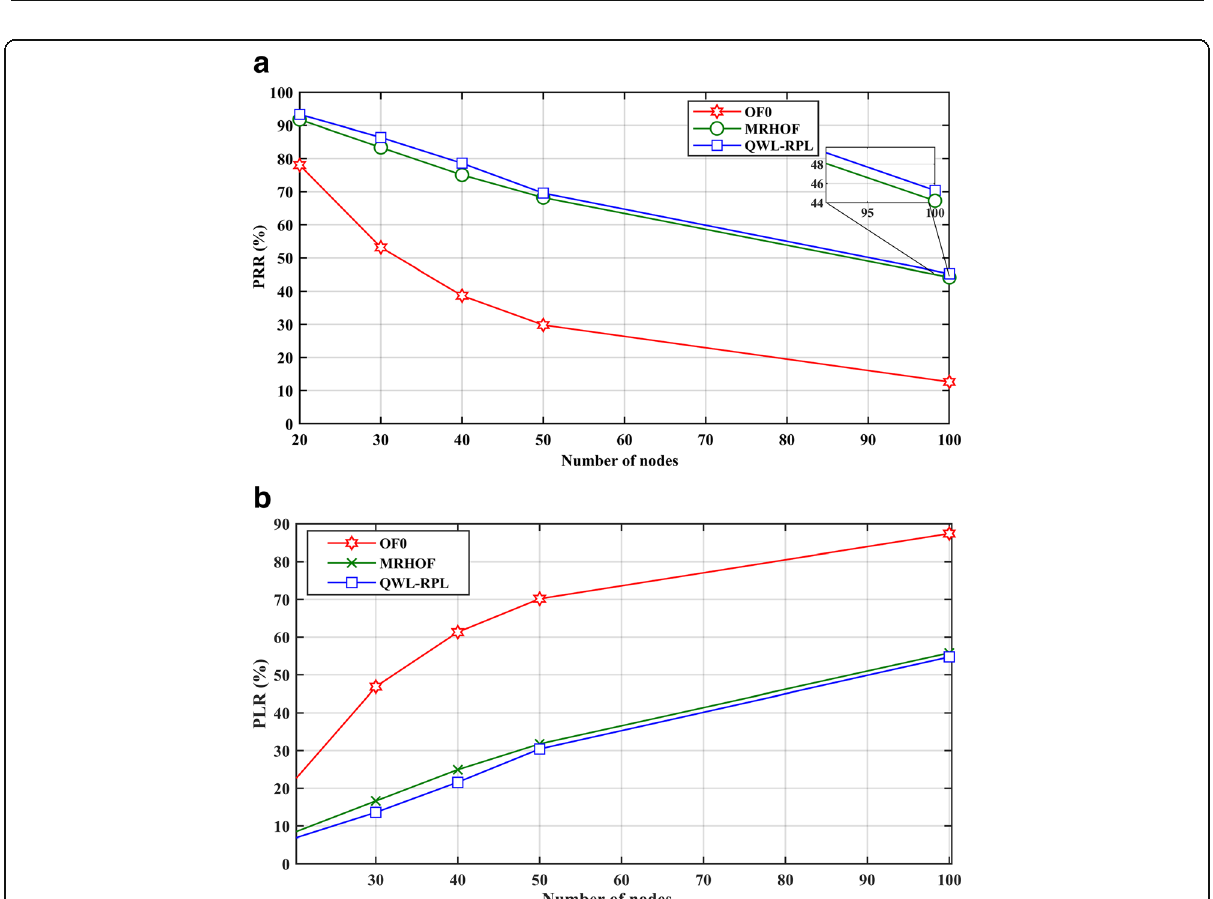
Fig. 7 Simulation analysis for the scenario I for the a packet reception ratio (%) and b packet loss ratio (%) versus number of